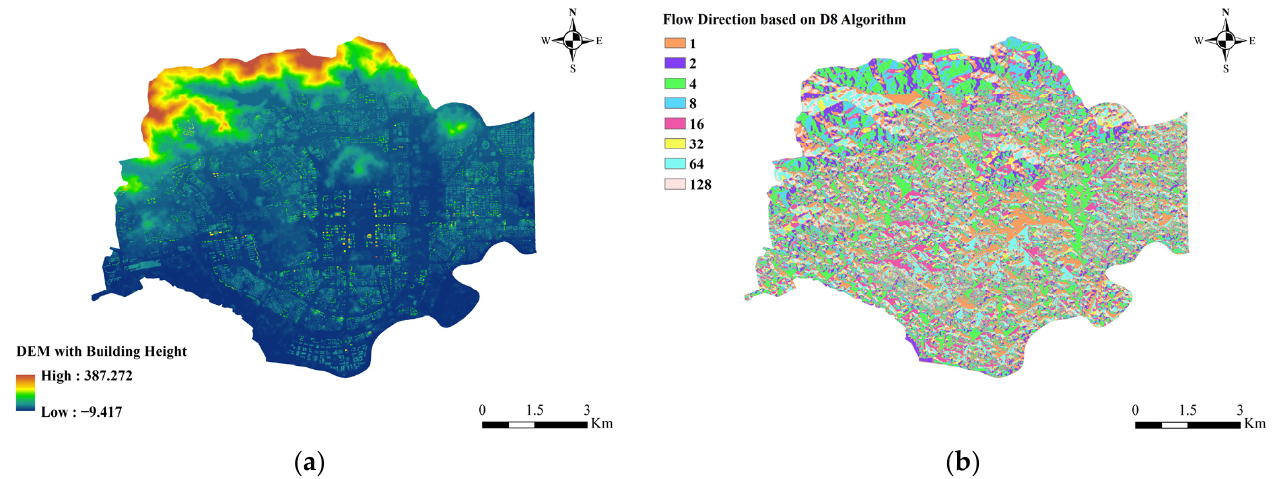
Figure 9. ( a ) DEM of superimposed building heights in Futian District; ( b ) Flow direction values of each grid in Futian District.